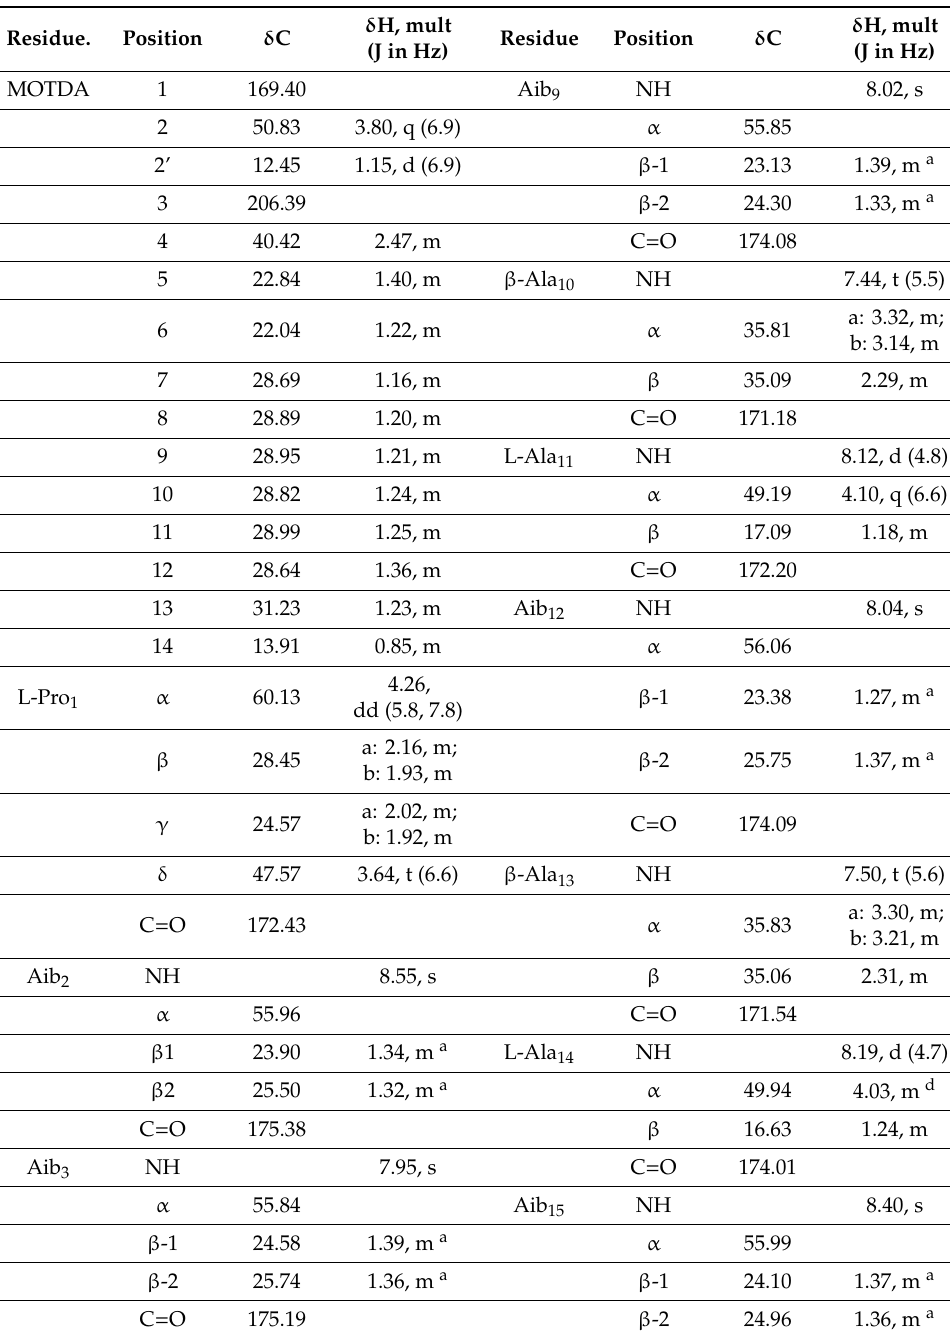
Table 1. 1 H- and 13 C-NMR data for compound 1 in DMSO (500 and 125 MHz for 1 H- and 13 C-,